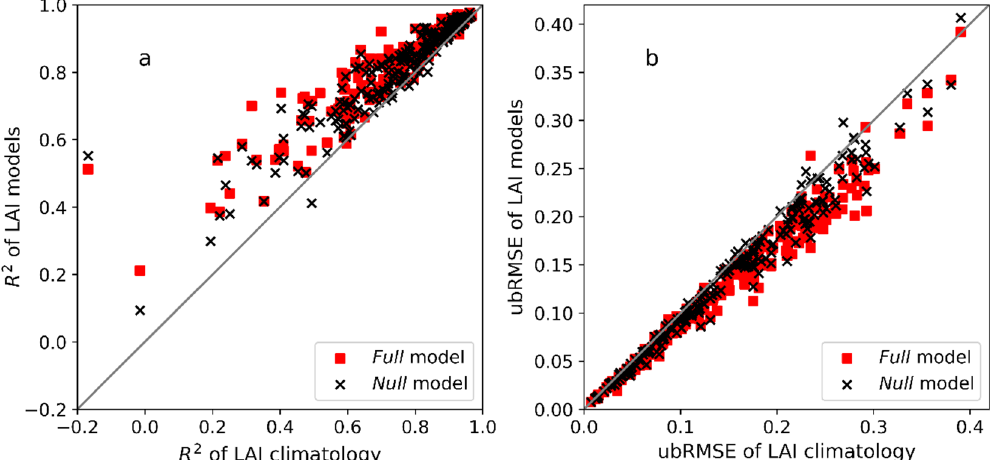
Remote Sens. 2021 , 13 , x FOR PEER REVIEW 12 of 21